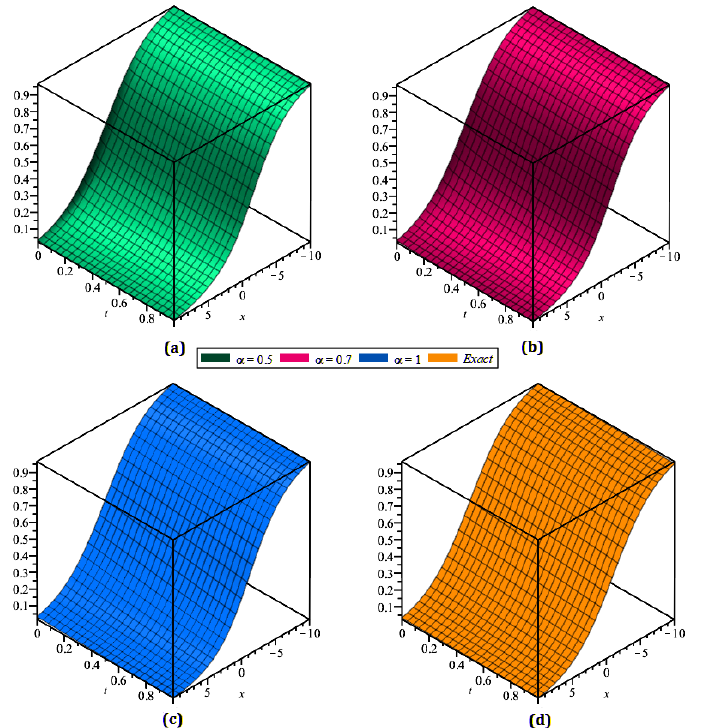
Figure 3. The actual and analytical solutions for v ( ϕ , τ ) at p = 2 from Example